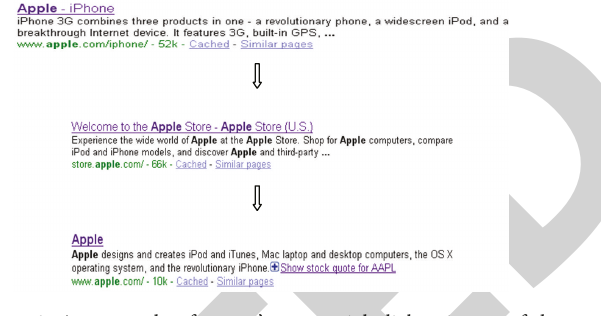
Figure 3: An example of a user’s sequential click snippets of the query “apple” in Google. Table 3: The context concept vector of a user clicking on the snippets in Figure 3 using steps for processing the sequential click